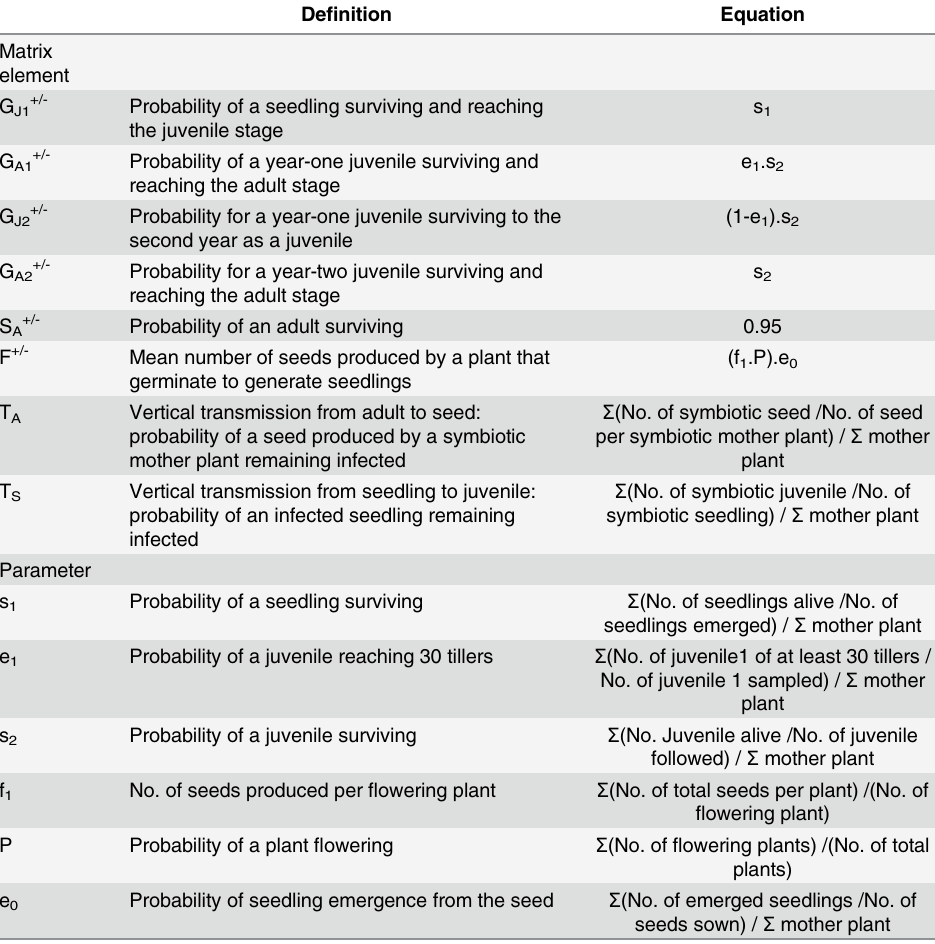
Table 1. Parameterization of elements in projection